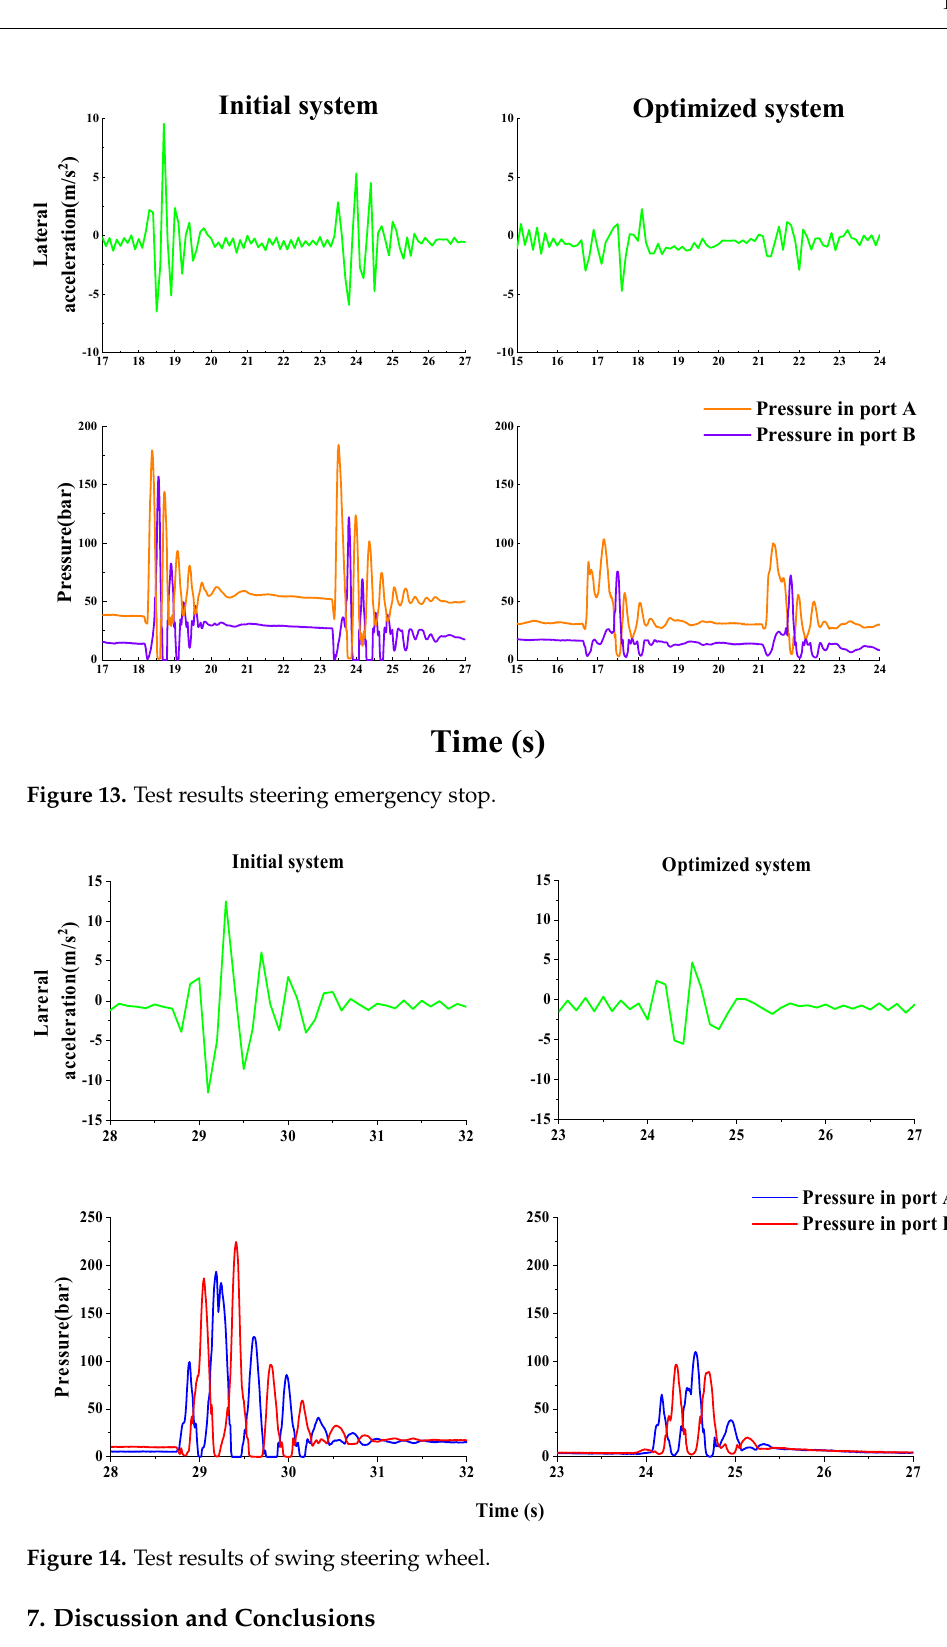
Figure 14. Test results of swing steering wheel.